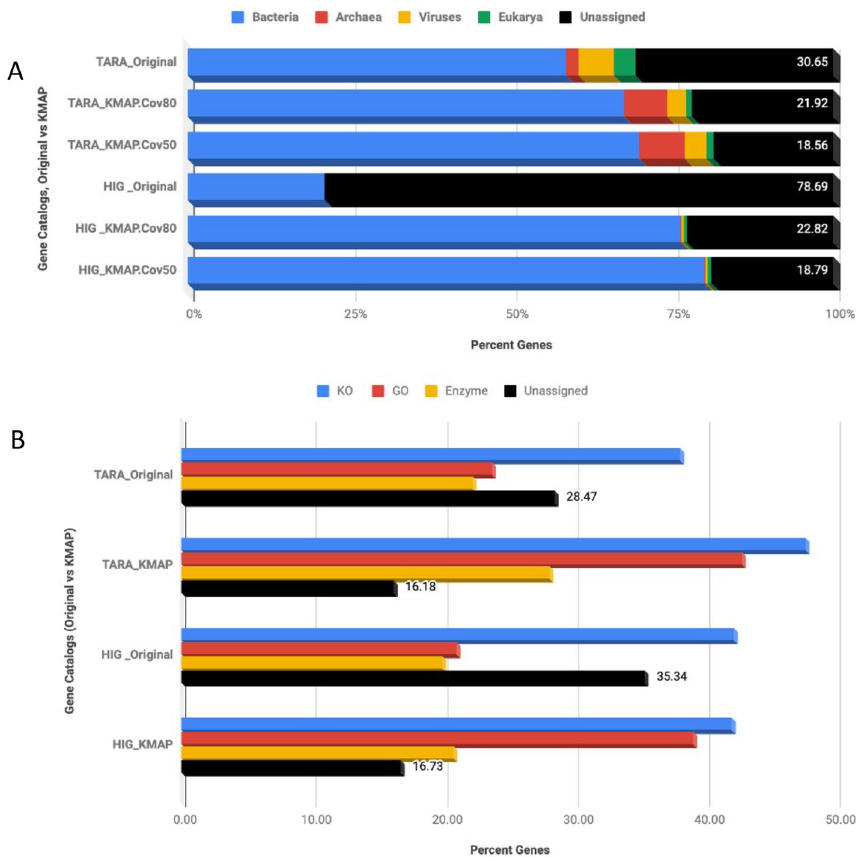
Figure 2. Examples of improved results in gene assignment. ( A ) Taxonomic coverage of existing gene catalogs, original versus re-annotation. ( B ) Functional coverage of public gene catalogs, original (2012) versus re-annotation (2018). HIG human integrated gut; Cov80 and Cov50 mean coverages of 80% and 50%,